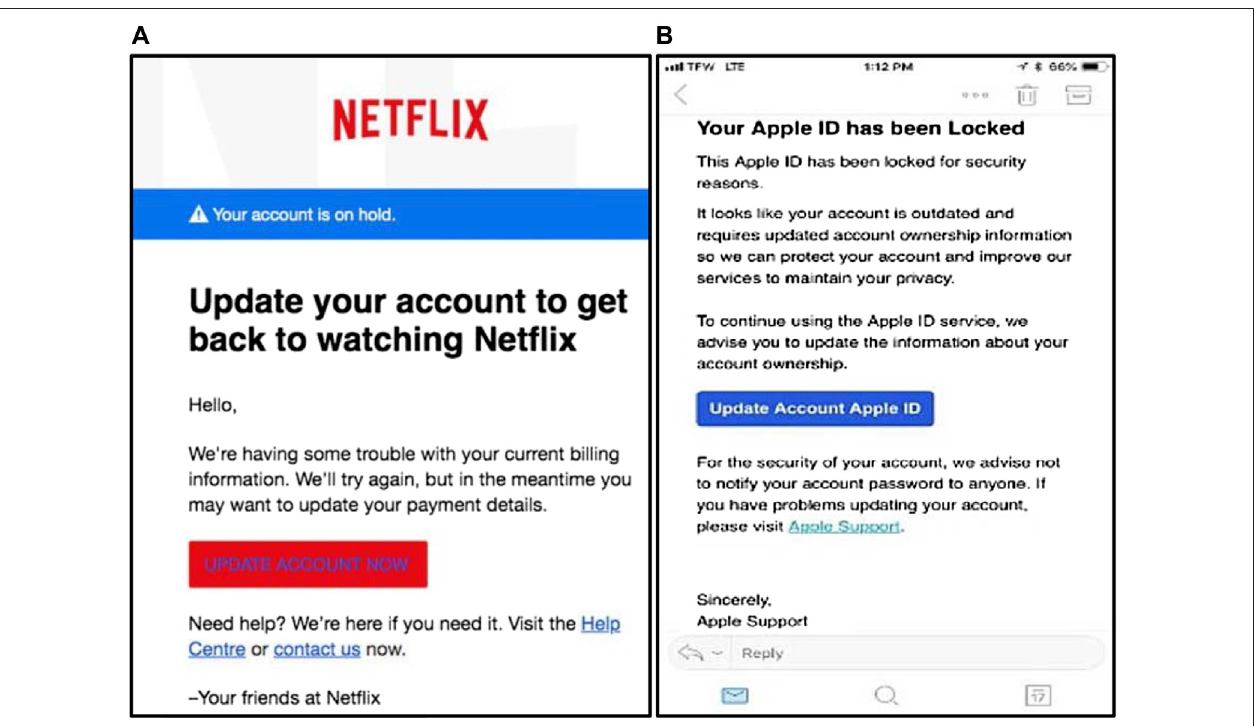
FIGURE 4 | Screenshot of the (A) Net fl ix scam email and (B) fraudulent text message (Apple) (Keck, 2018; Rhett, 2019)